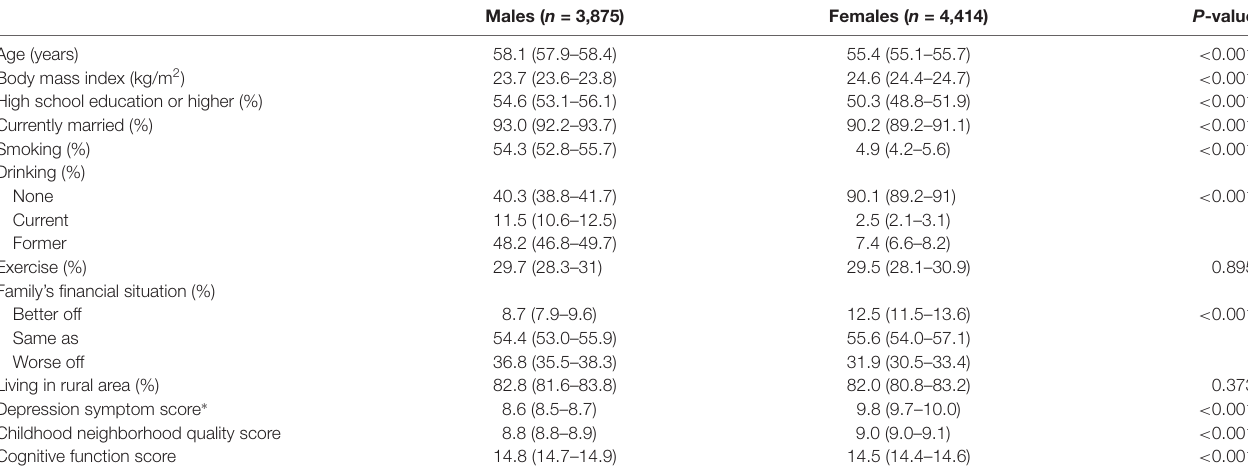
TABLE 1 | Characteristics of participants.